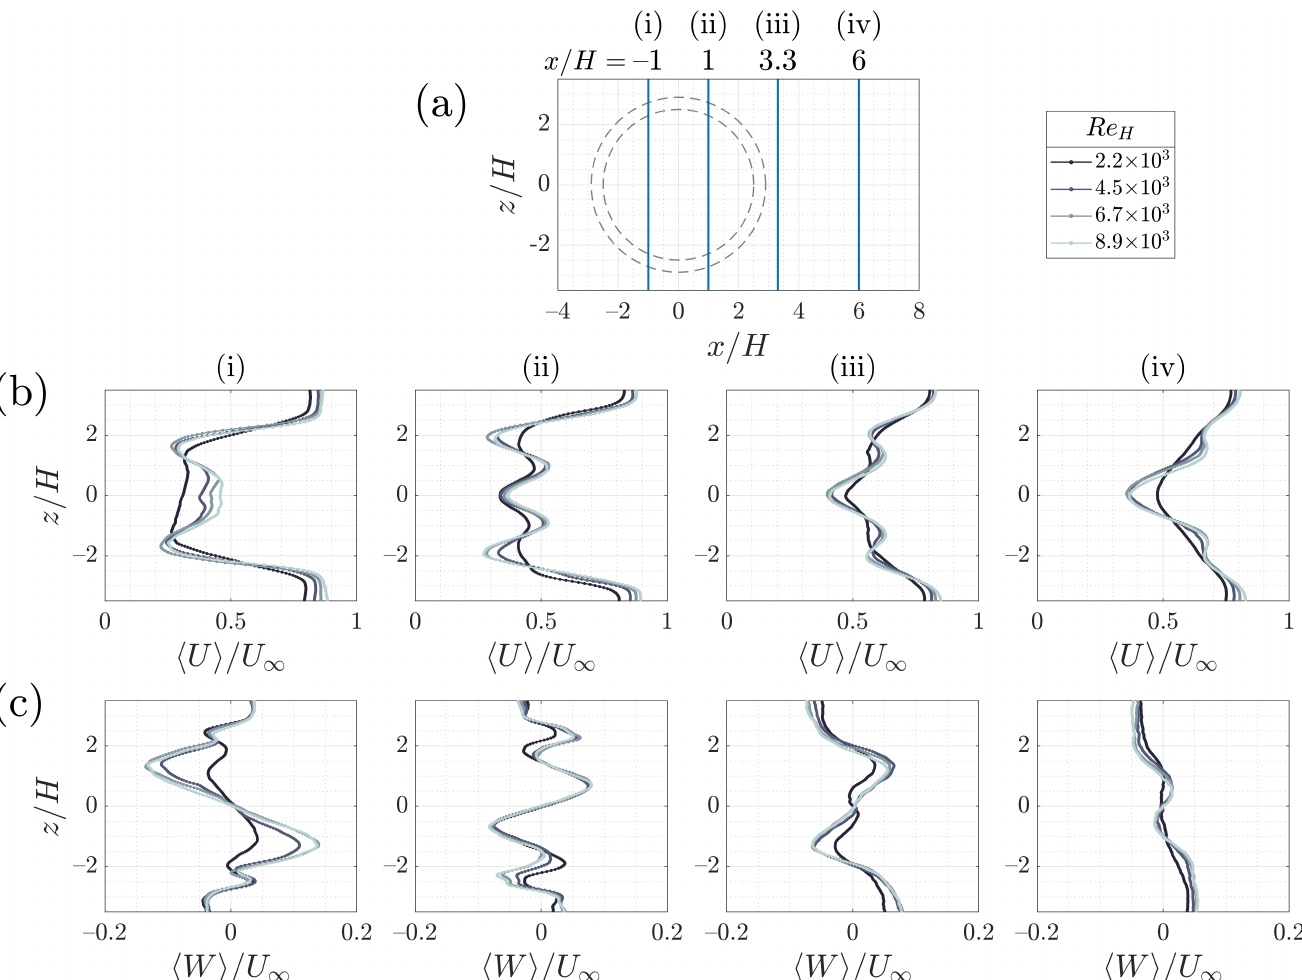
Figure 7. Spanwise profiles of normalized mean velocity components at the top plane ( y / H = 1.1) for four different Re . Data are normalized by the free-stream velocity, U ∞ . ( a ) A reference for the streamwise locations of the profiles showing the four streamwise locations from which data were extracted: ( b ) streamwise component, (cid:104) U (cid:105) ; ( c ) spanwise component, (cid:104) W (cid:105)